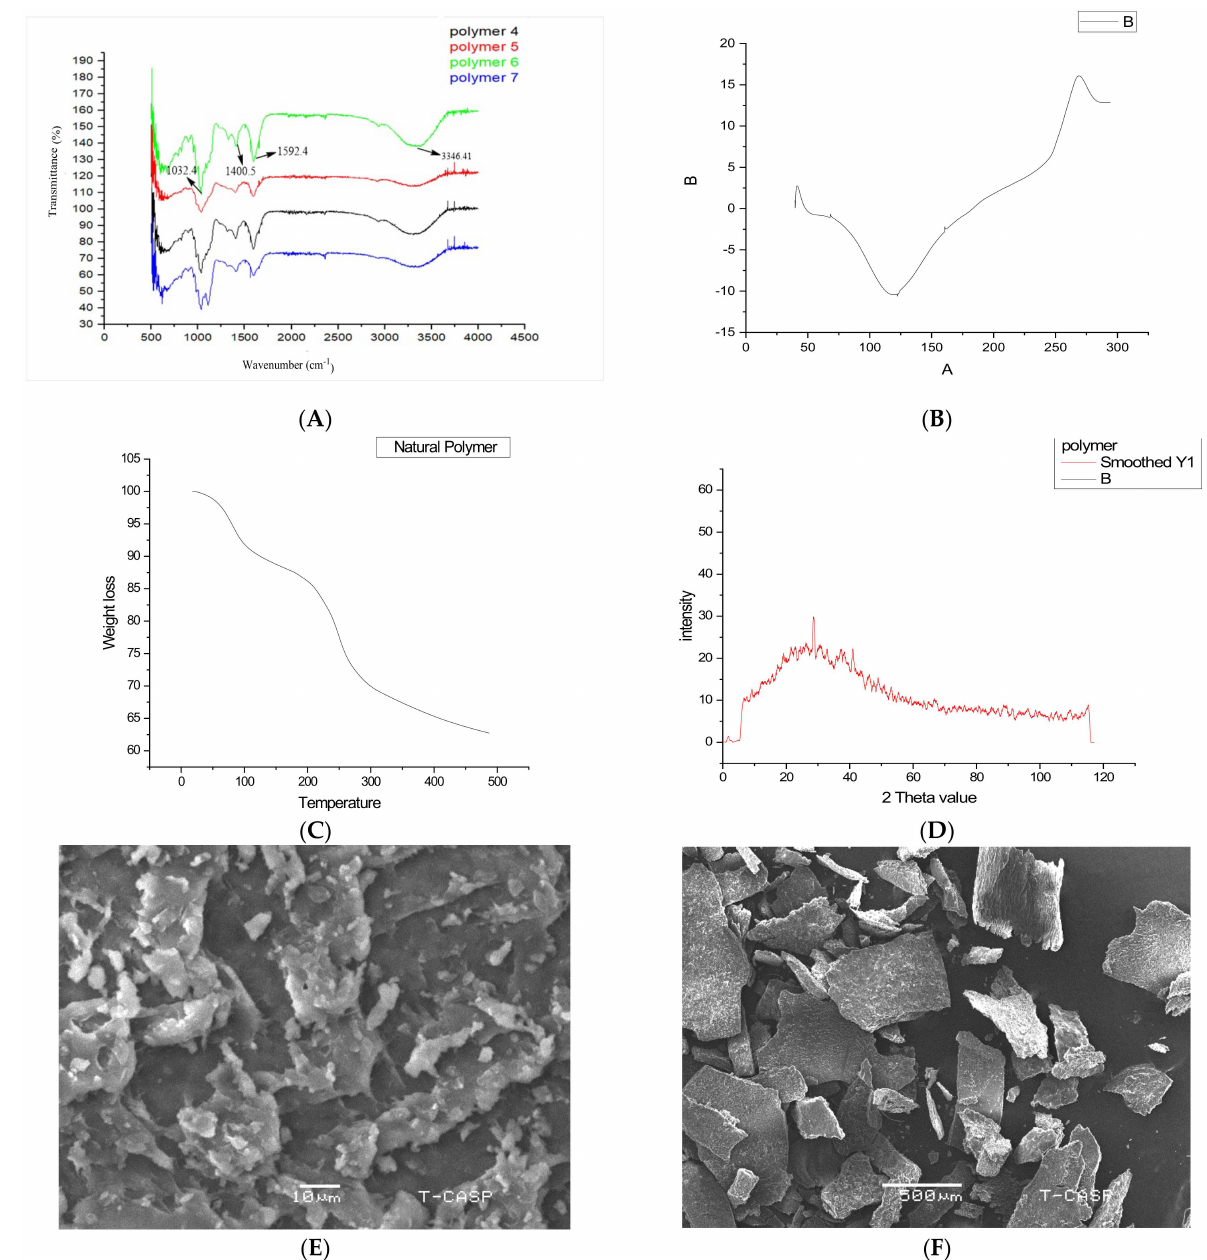
Figure 1. Characteristics of Ocicum: ( A ) FTIR, ( B ) DSC, ( C ) TGA, ( D ) XRD, and ( E , F ) SEM micro- graphs at different